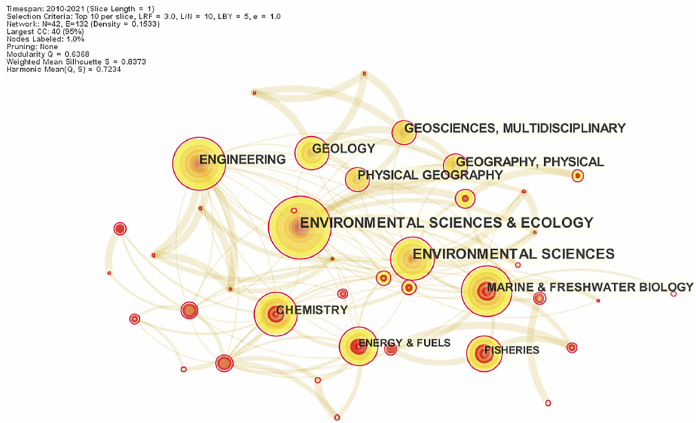
Figure 1. Network graph of discipline distribution in marine